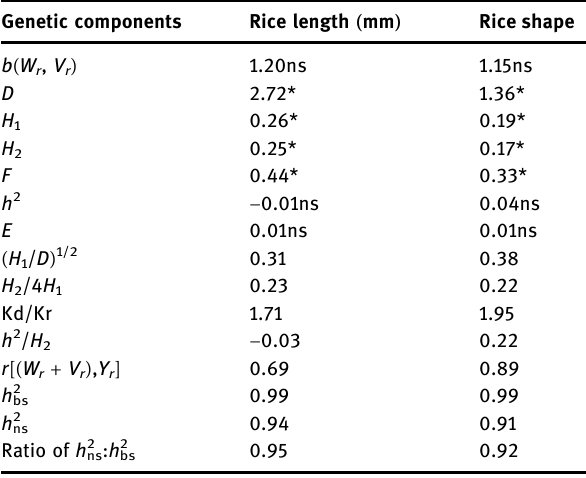
Table 3: Estimates of genetic components of variation for